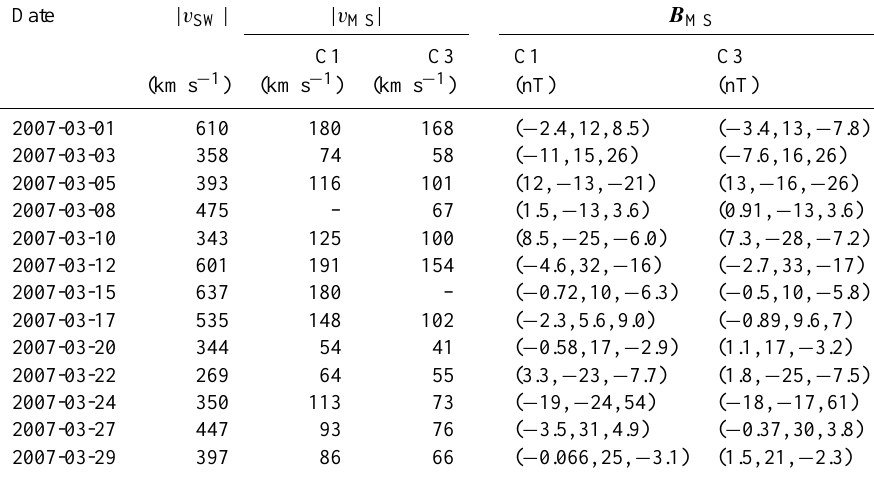
Table 2. Magnetosheath and solar wind data. The solar wind speed and magnetic field were measured by the Wind spacecraft. The mag- netosheath values are mean values of the first 10min Cluster 1 and 3, respectively, spent in the magnetosheath after the last plasmoid was seen.